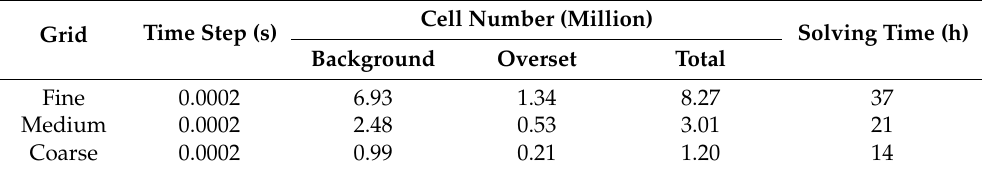
Figure 12. Comparative view of the three CFD mesh schemes: ( a ) fine mesh; ( b ) medium mesh; ( c ) coarse mesh. Table 5. Grid parameters of each mesh scheme.